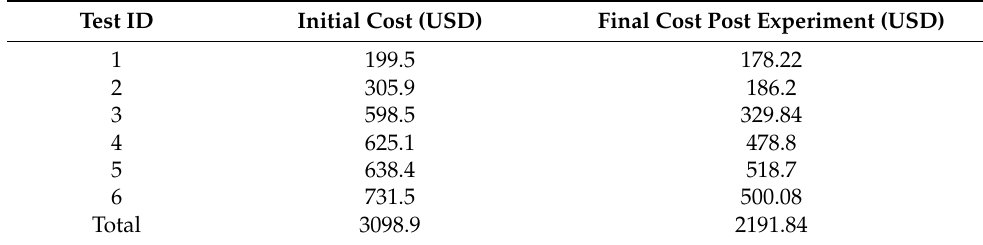
Table 5. The apportionment of repair